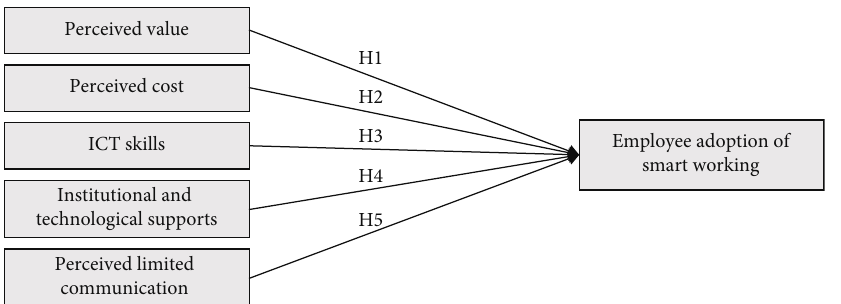
Figure 1: The conceptual model of the study.